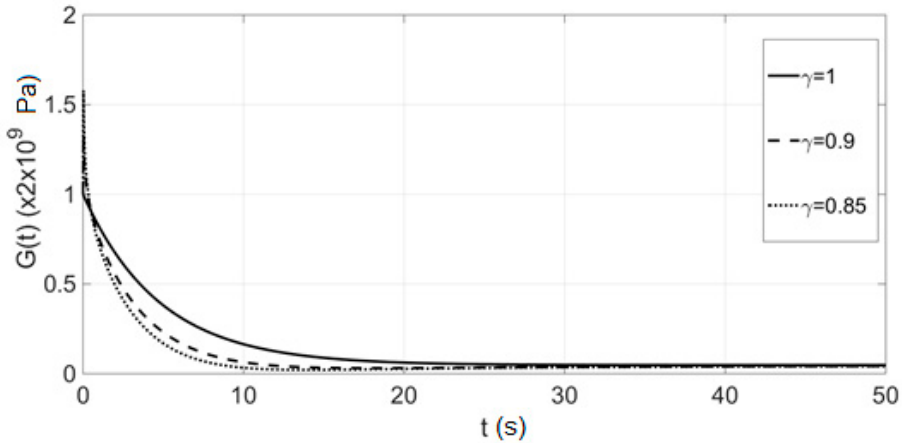
Figure 12. Variation of the relaxation modulus versus time for γ = 1, 0.9, 0.85 in the initial space.